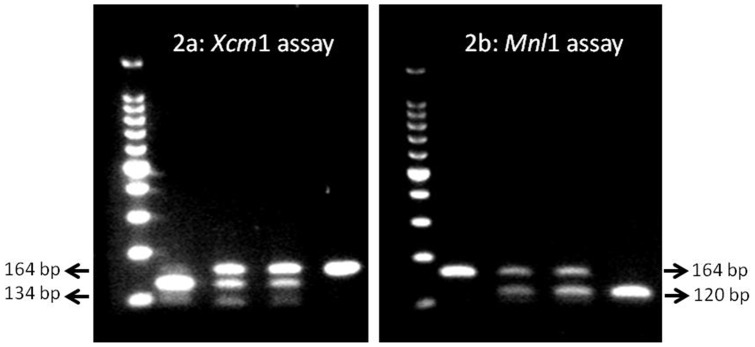
dCAPS procedures for the detection of the wild type tryptophan and mutant serine amino acid residues at ACCase codon position 1999: (a) XcmI restricted (134 bp) and unrestricted (164 bp) fragments correspond to sensitive W1999 and resistant S1999 ACCase alleles respectively.(b) MnlI restricted fragment is indicative of the mutant serine allele (120 bp) while the undigested band (164 bp) corresponds to the wild type tryptophan allele. Heterozygous plants display one each of the restricted and unrestricted PCR fragment in both assays.